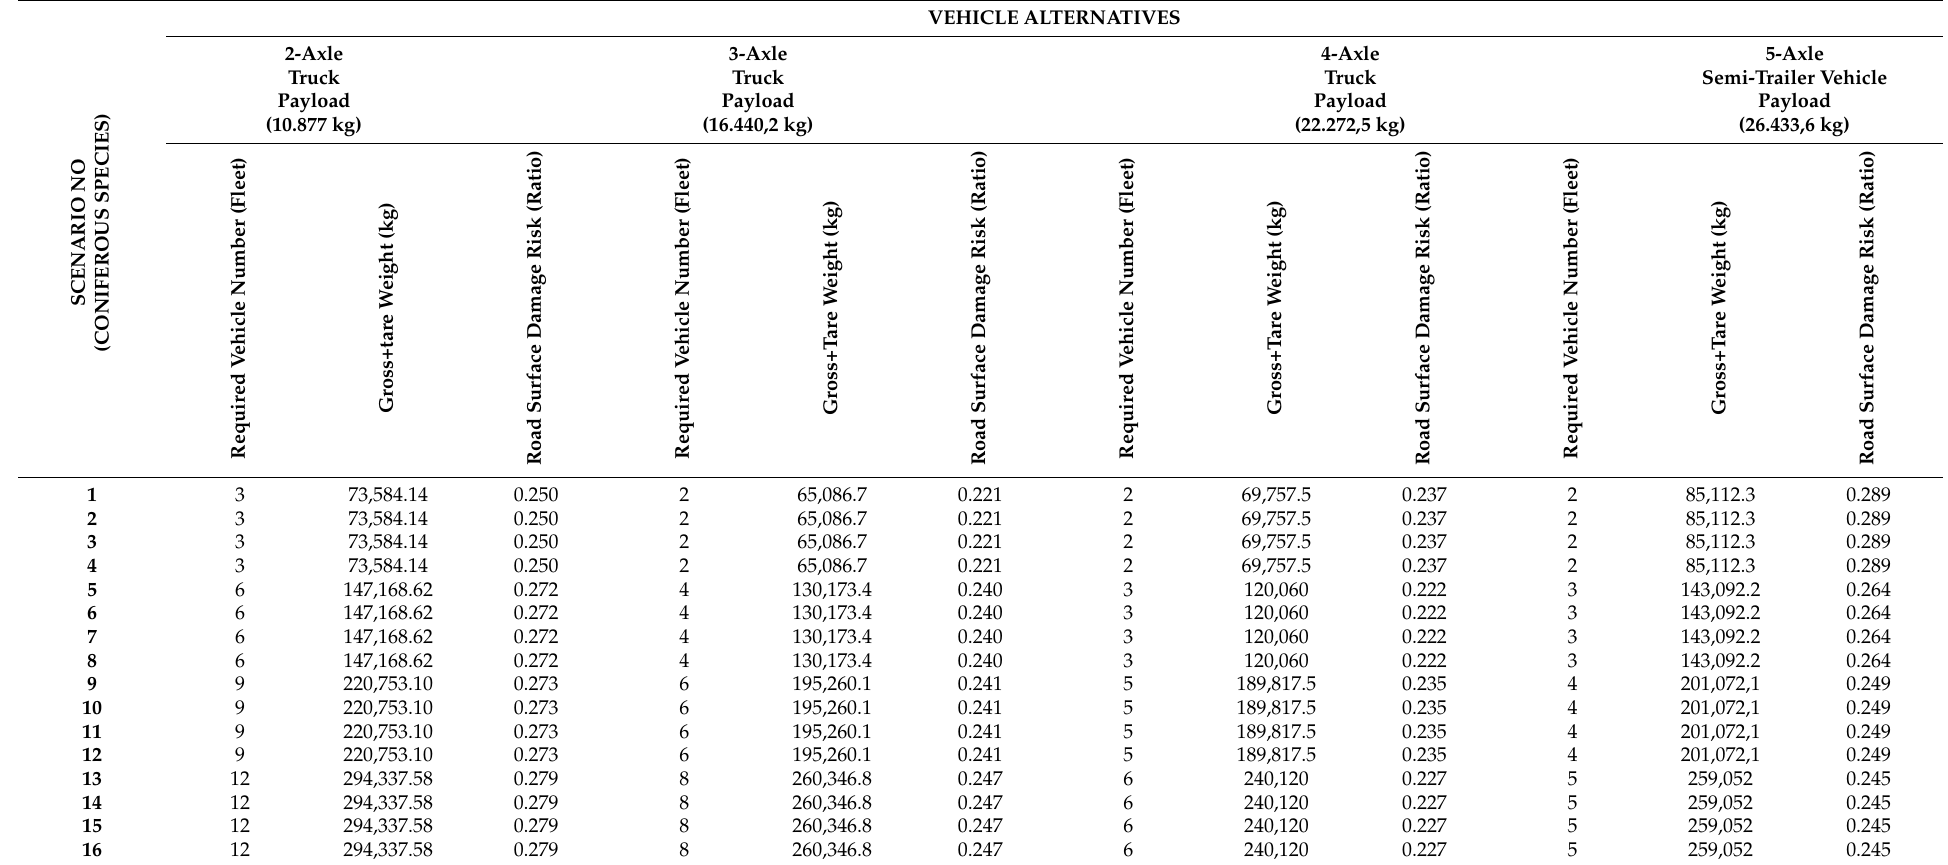
Table 19. Road surface risk values in terms of coniferous species for vehicle